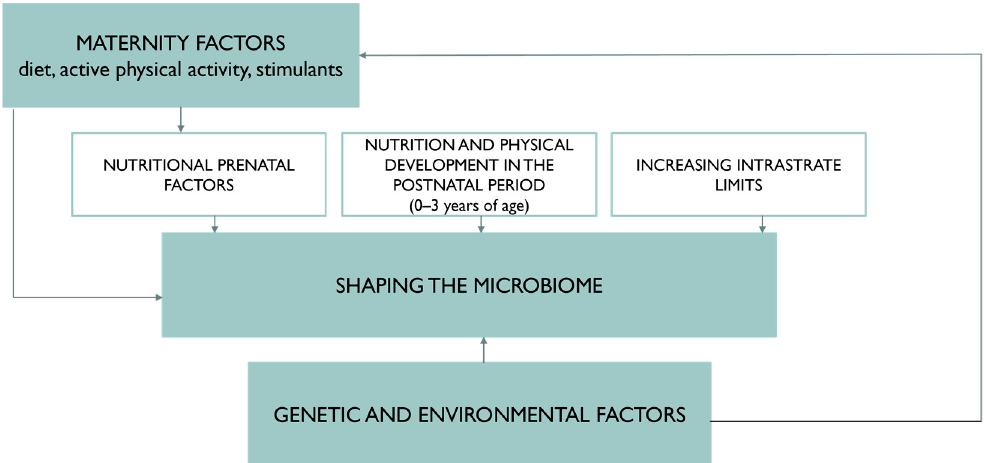
Figure 2. Hypothesis explaining the effect of microbiome programming.